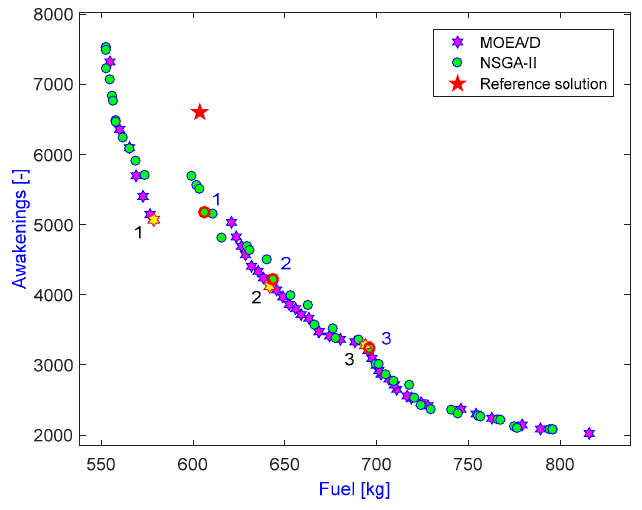
Figure 3. Comparison of optimal solutions obtained by NSGA-II, MOEA/D, and the reference case.